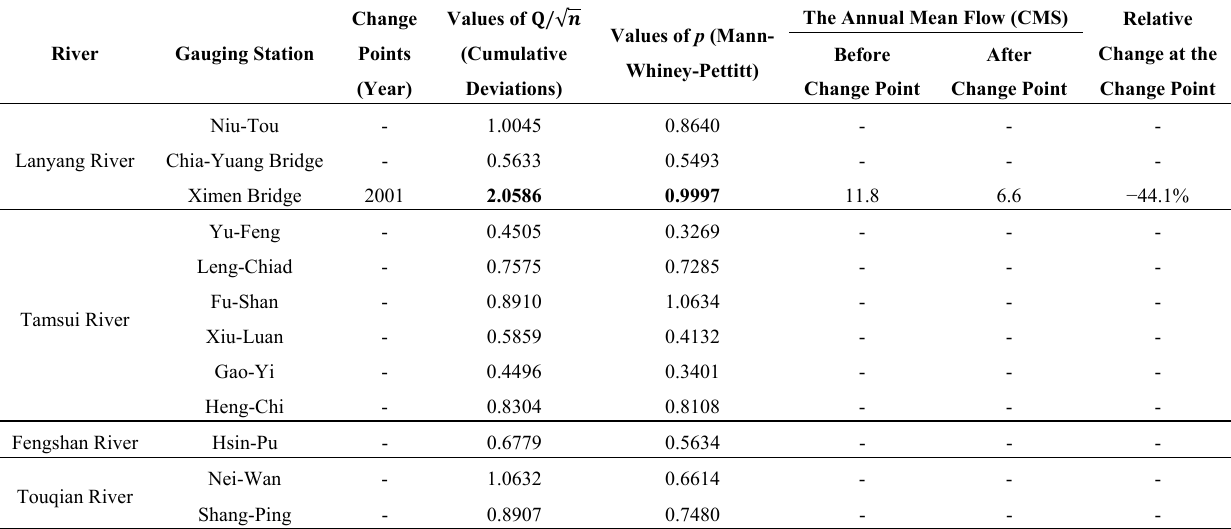
Table 3. Change points determined by using the cumulative deviations and Mann-Whiney-Pettitt methods.